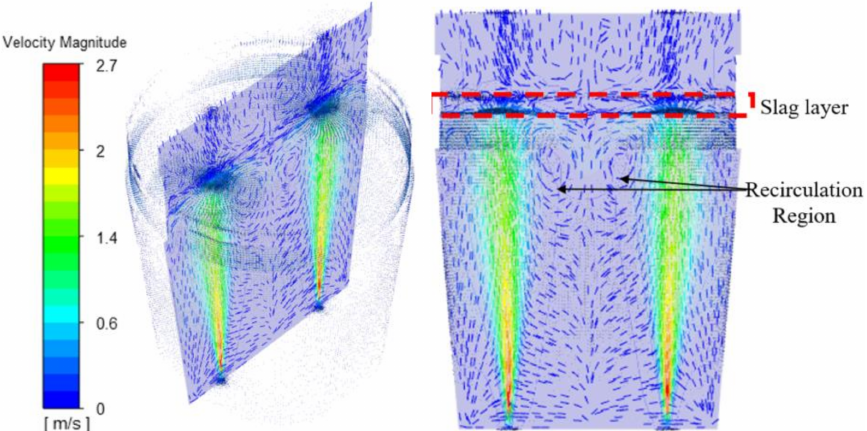
Figure 8. Velocity magnitude vector along the center plane showing areas of